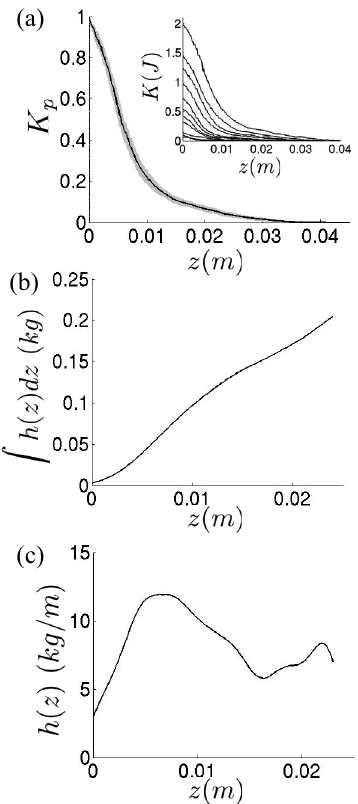
Figure 3. (a) Inset: K versus z of s = 0 intruder impacting sand. Each curve represents a trajectory of a di ff erent ˙ z i . Main panel: K p , a vg versus z , as determined from all pairs of K ( z ) trajectories of the inset plot. The gray region surrounding the curve indicates the standard deviation from the mean of K p . (b) z (c) h ( z ) versus z , showing oscillations about a constant value.